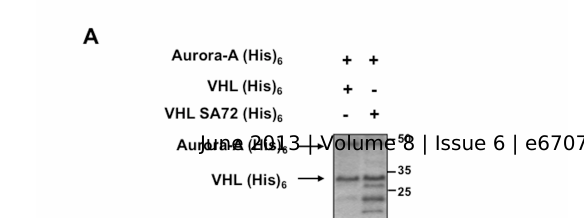
Figure 5. pVHL is phosphorylated on Ser72 by Aurora-A in vitro . A- Purified recombinant 6xHis- tagged pVHL30 [VHL(His) 6 ] (lane 1) or mutant 6xHis- tagged pVHL30 S72A [VHLSA72(His) 6 ] ( (lane 2) were incubated in the presence of [γ- 32 P] ATP and recombinant Aurora-A(His) 6. Samples were separated by SDS-PAGE and the gel was stained with Coomassie Blue (higher panel). pVHL phosphorylation status was analysed by autoradiography (lower panel). The asterisk (*) indicate the pVHL protein. B-Localization and sequence of the putative Aurora-A phosphorylation site on pVHL.